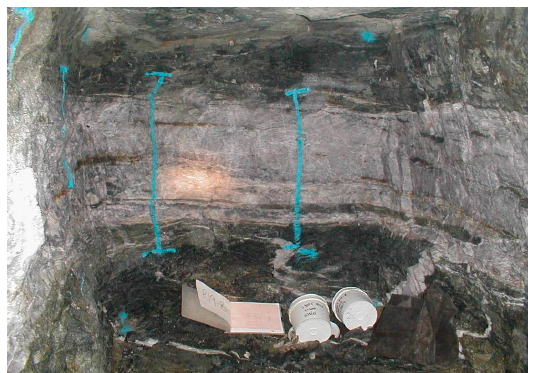
Figure 6. Target Block Main vein exposed in a raise, where the structure comprises a composite package of narrow veins separated by screens of wallrock. Vertical blue lines mark location of channel samples.